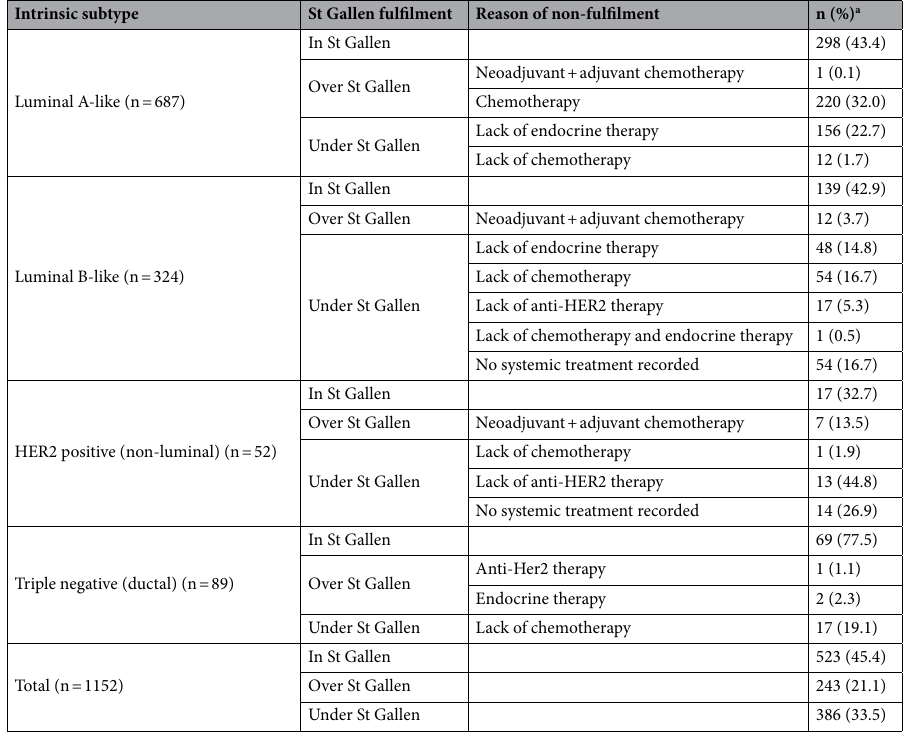
Table 2. Description of St Gallen fulfilment/non-fulfilment according to breast cancer intrinsic subtypes. a Percentages refer to each intrinsic subtype.